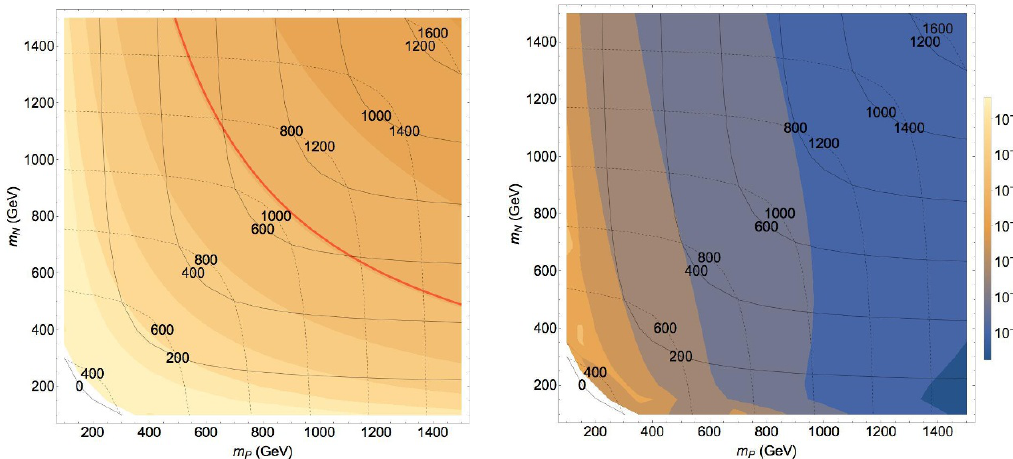
Figure 1 . Branching ratios for h ! XX (left) and h ! XZ (right) decays due to mediator fermion loops in the m P - m N plane for (cid:21) = 1, (cid:11) x = 10 (cid:11) , and m x = 15 GeV. The solid (dashed) black contours indicate m 1 ( m 2 ) masses, while the solid red line shows the sensitivity of the most sensitive current LHC searches